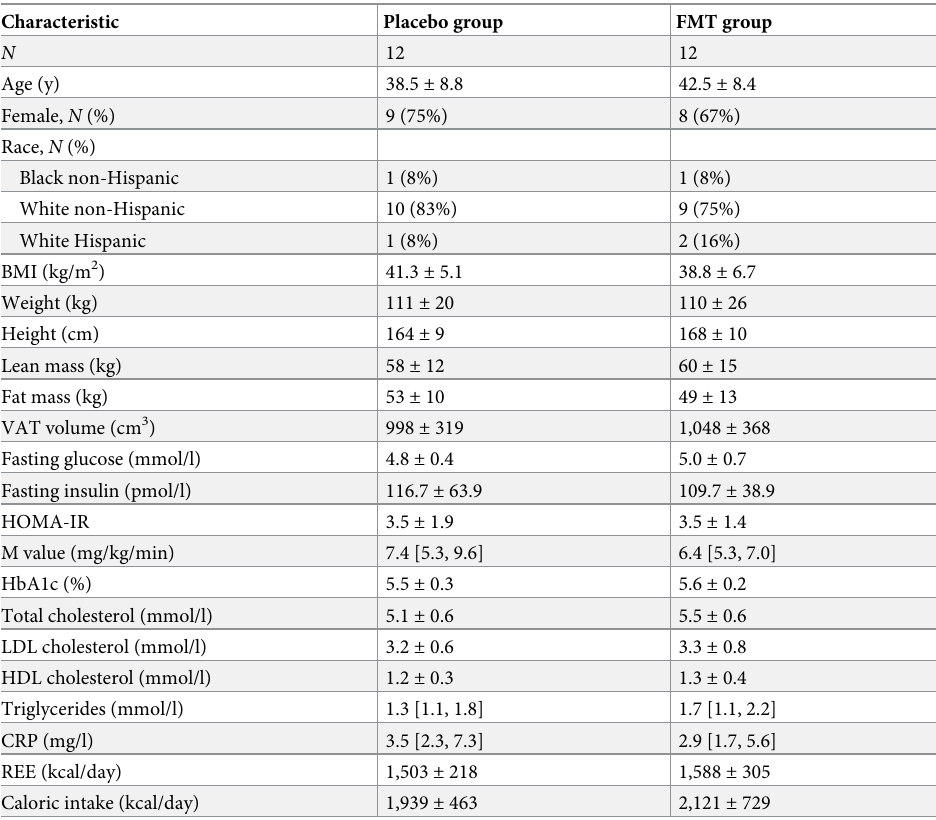
Table 1. Baseline characteristics of randomized participants.